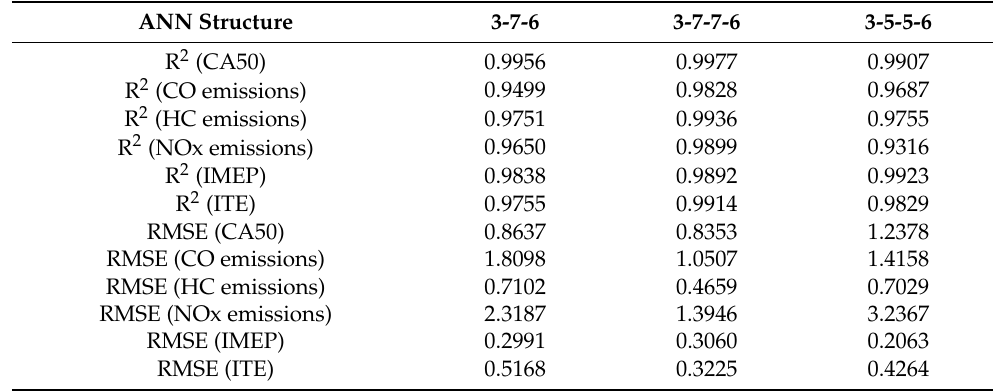
Table 3. The R 2 coefficient and RMSE calculated for the training dataset based on the different structures of the ANN model.